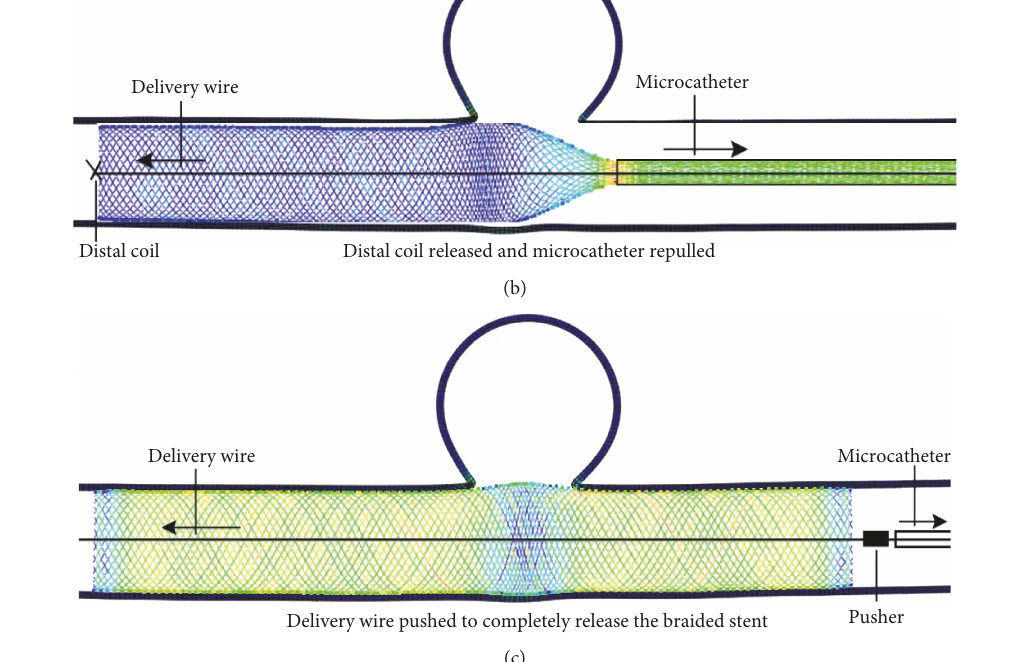
Figure 5: Deployment procedure of fl ow diverter with compaction.